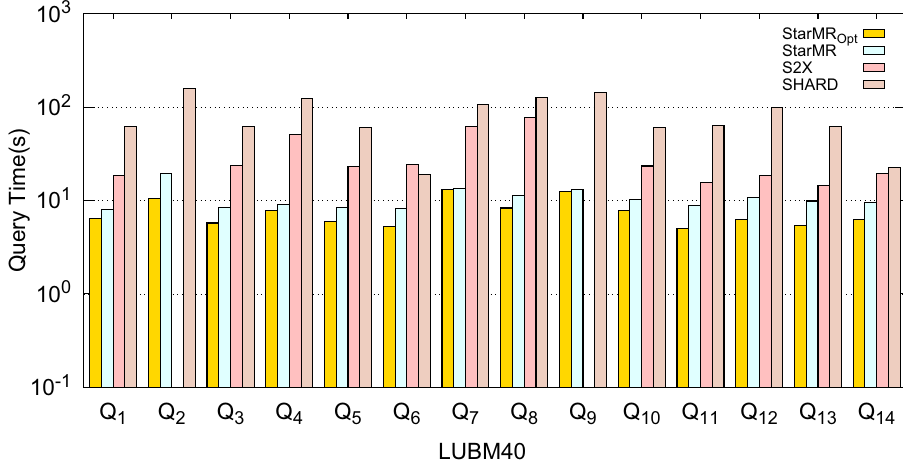
Fig. 8 Efficiency on